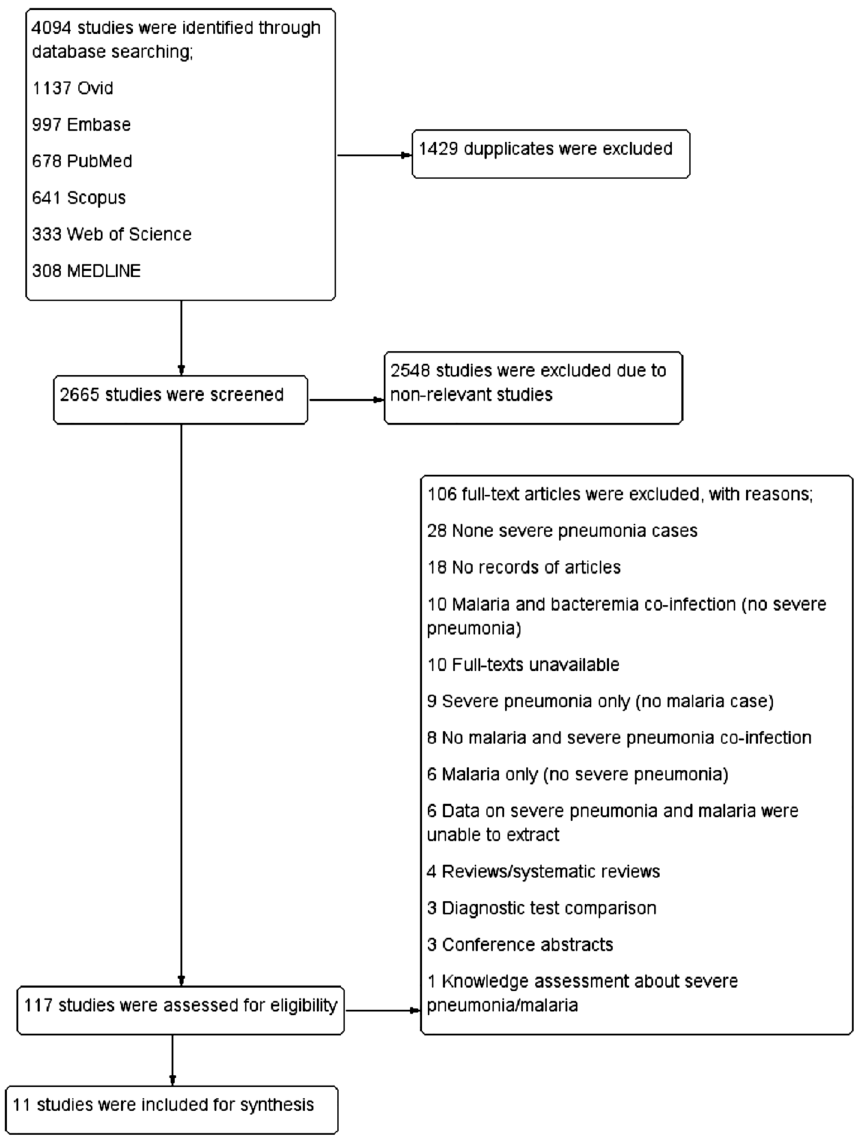
Figure 1. Flowchart for the study selection. Flowchart demonstrates the selection of potentially relevant